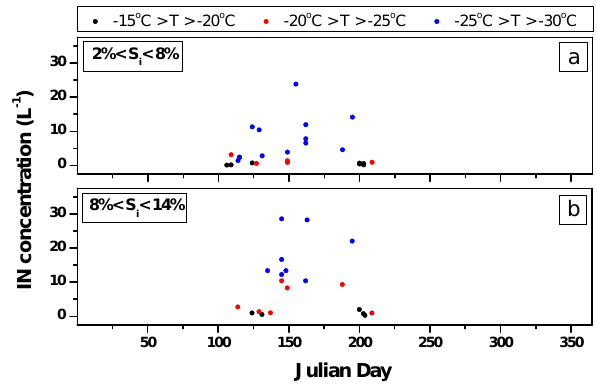
Fig. 7. Temporal evolution of the IN concentration for different tem- perature range and S i ranges of (a) [2,8]% and (b) [8,14]%.